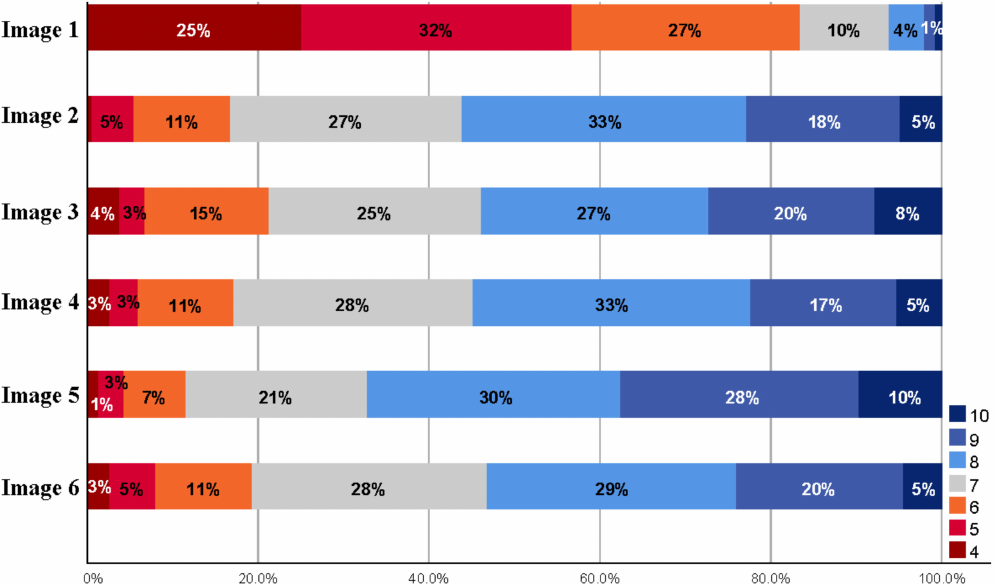
Figure 10. Distribution of grades in the proposed renovation